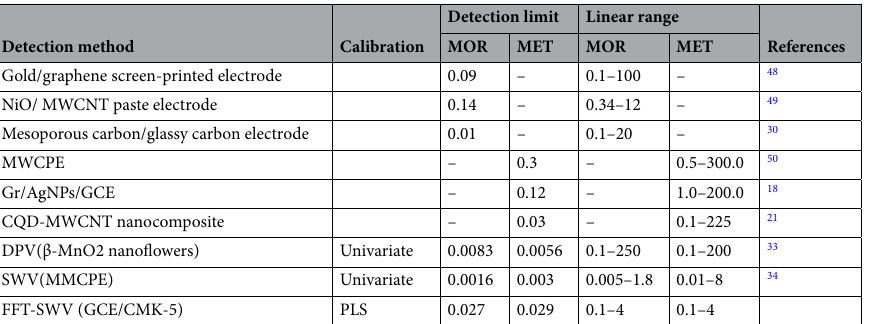
Table 3. Comparison of the proposed sensor for MOR and MET with reported detection